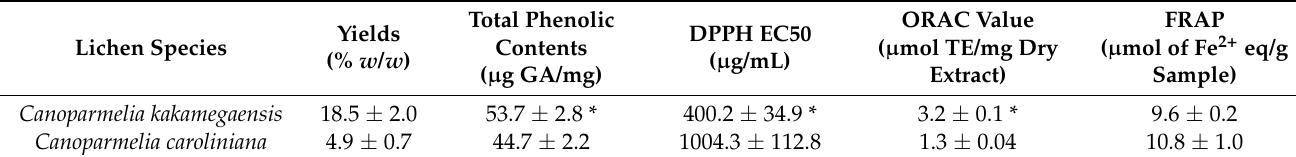
Table 2. Extraction yield, total phenolic content and antioxidant potential (DPPH, ORAC and FRAP assays) of the lichen extracts Canoparmelia kakamegaensis and Canoparmelia caroliniana . Values are expressed as mean ± standard deviation. * Indicates statistically significant differences ( p < 0.05) between lichen